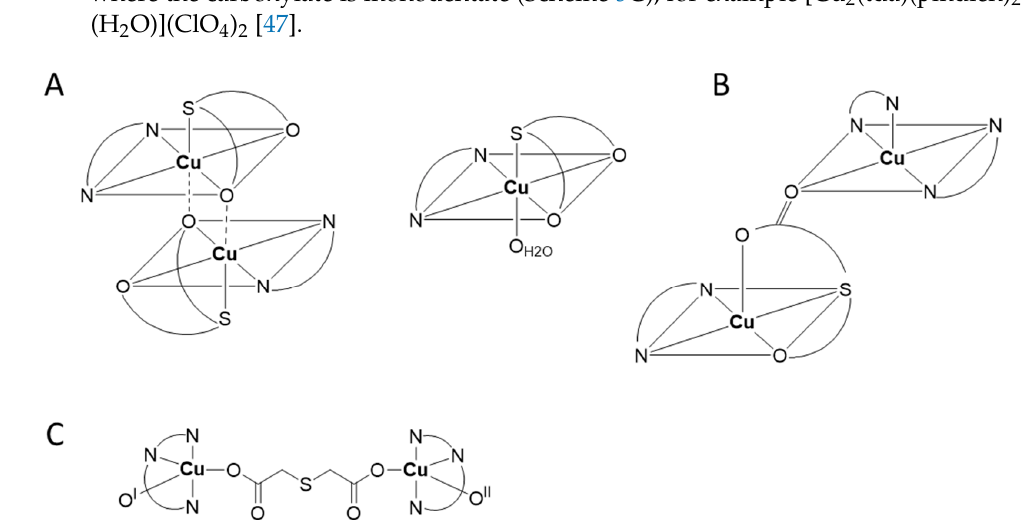
Scheme 5. Possible variants of coordination modes of thiodiacetic